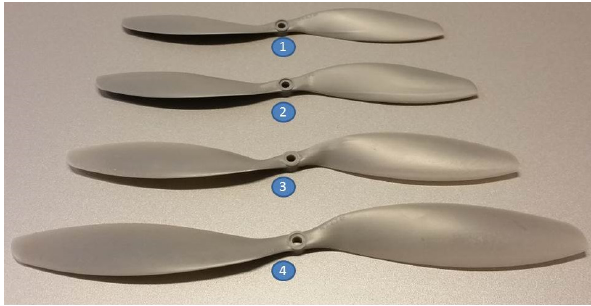
Figure 6: Four different propellers used in the design optimization and validation tests.